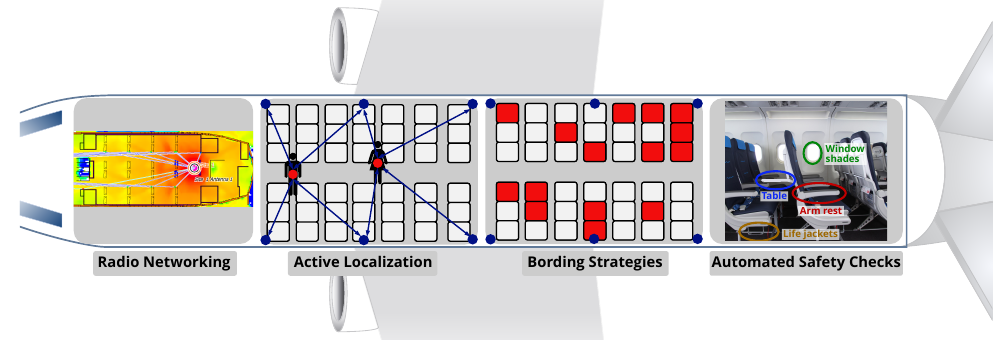
Figure 1. Potentials of integrated communication, localization and sensing for connected